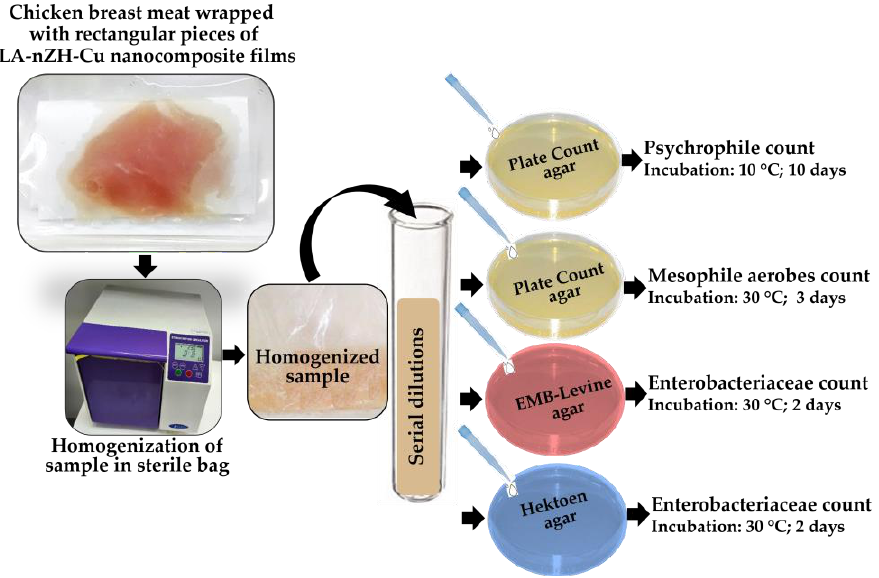
Figure 4. Evaluation of the PLA-nZH-Cu nanocomposite film’s role in the microbiological quality of chicken breast. Each test was carried out consecutively for 0, 10, and 20 days of storage.